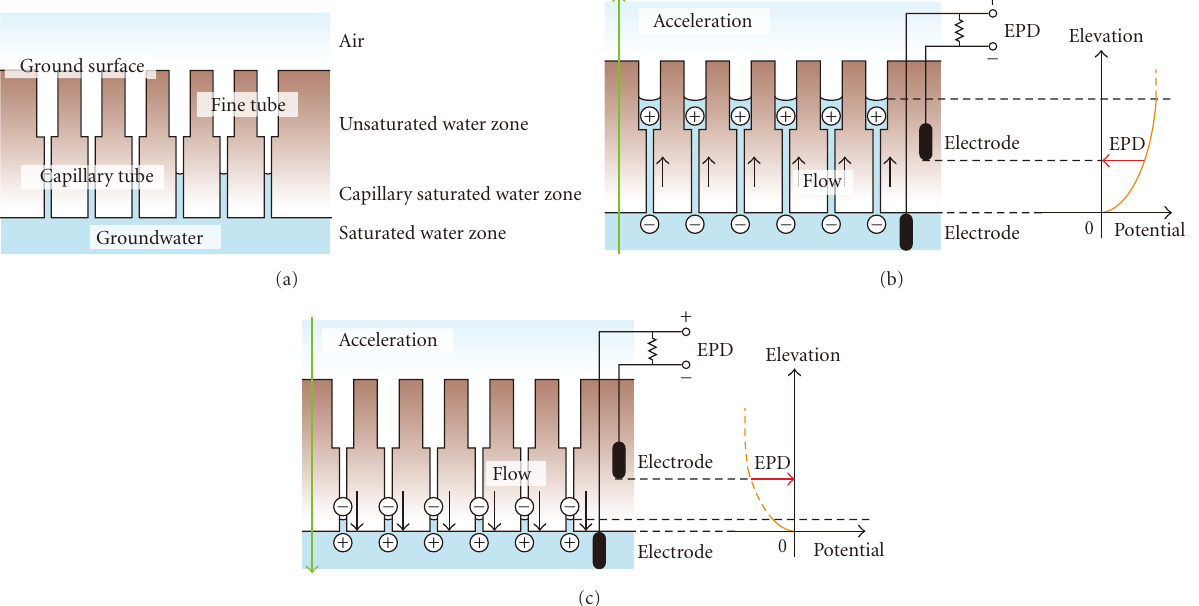
Figure 6: Generation model of the induced earth potential di ff erence (EPD). (a) Model of the topsoil from the viewpoint of water saturation/unsaturation. (b) Generation of a negative EPD signal induced by streaming potential because of the upward flow of water along the tubes. (c) Generation of a positive EPD signal induced by streaming potential because of the downward flow of water along the